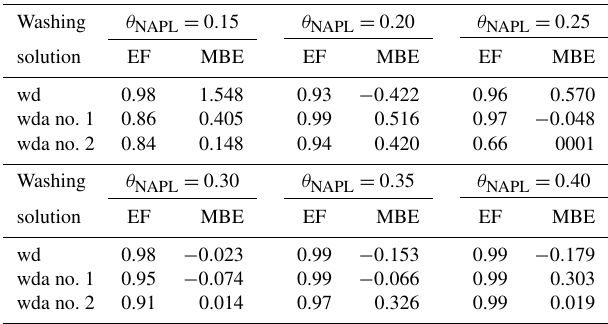
Table 2. Model efficiency (EF) and mean bias error (MBE) statisti- cal indices, referring to measured and predicted (Eq. 10) volumetric NAPL content ( θ NAPL ), calculated in the range of model applica- bility (0 . 15 ≤ θ NAPL ≤ 0 .